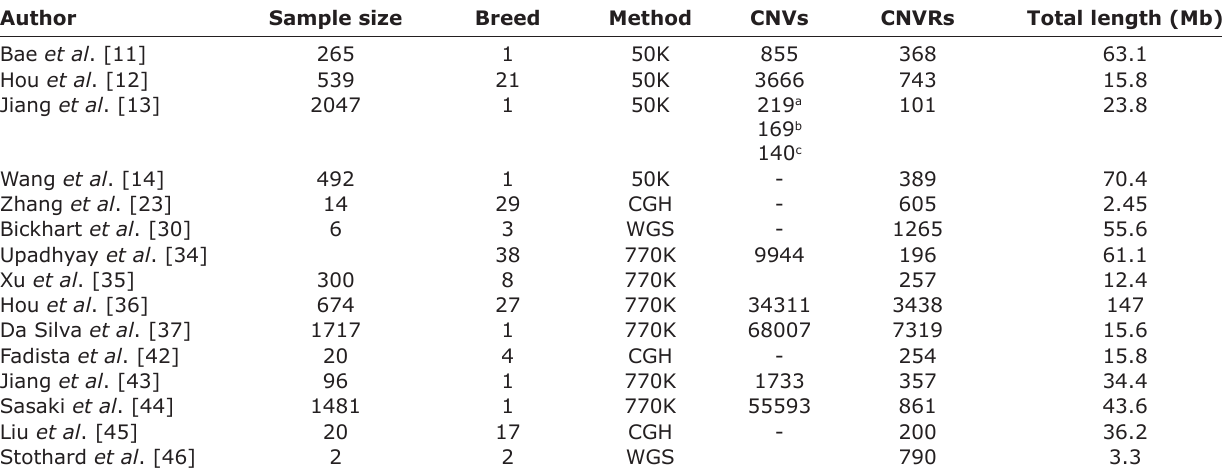
Table-1: CNVs detection studies in cattle using different approaches.